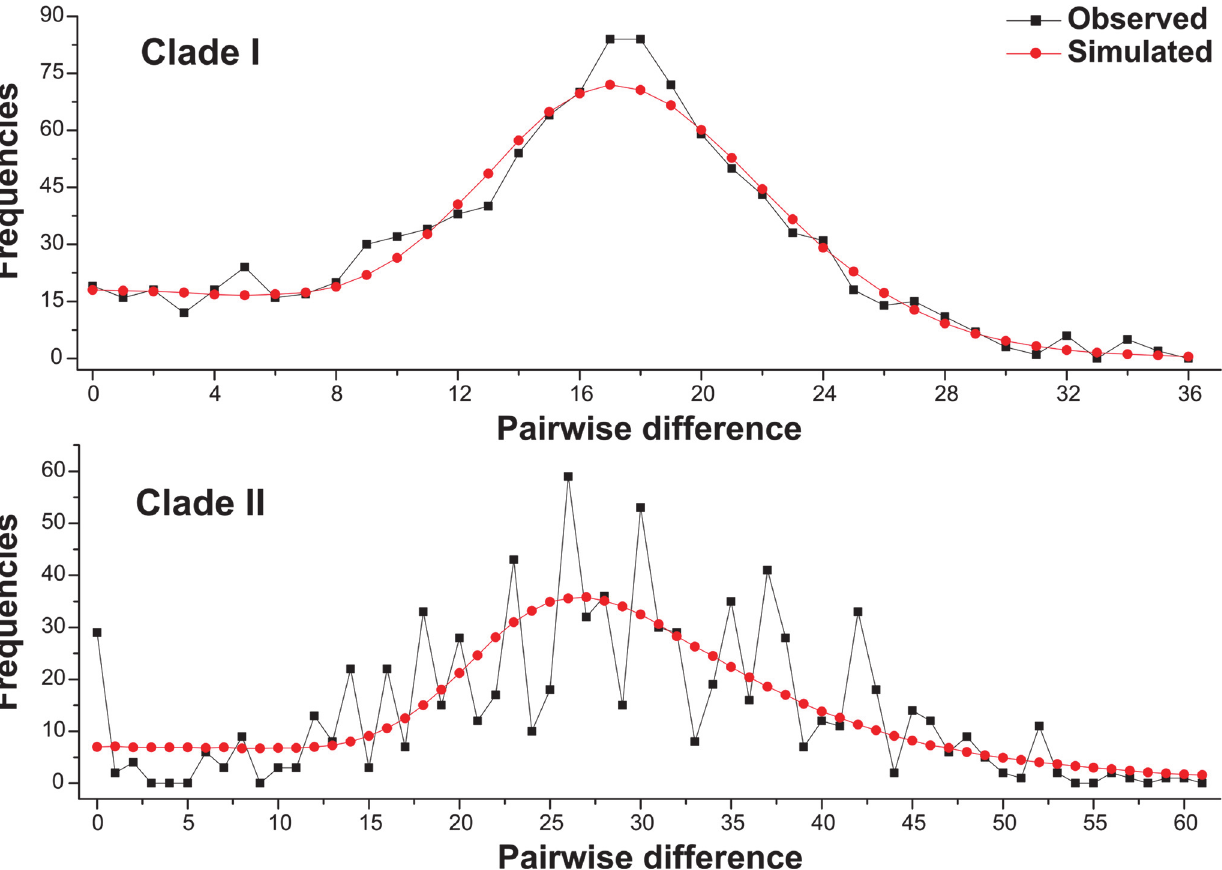
Fig 5. Mismatch distribution analysis for the Clade I and Clade II. The line charts represent the observed frequencies of pairwise differences among haplotypes.